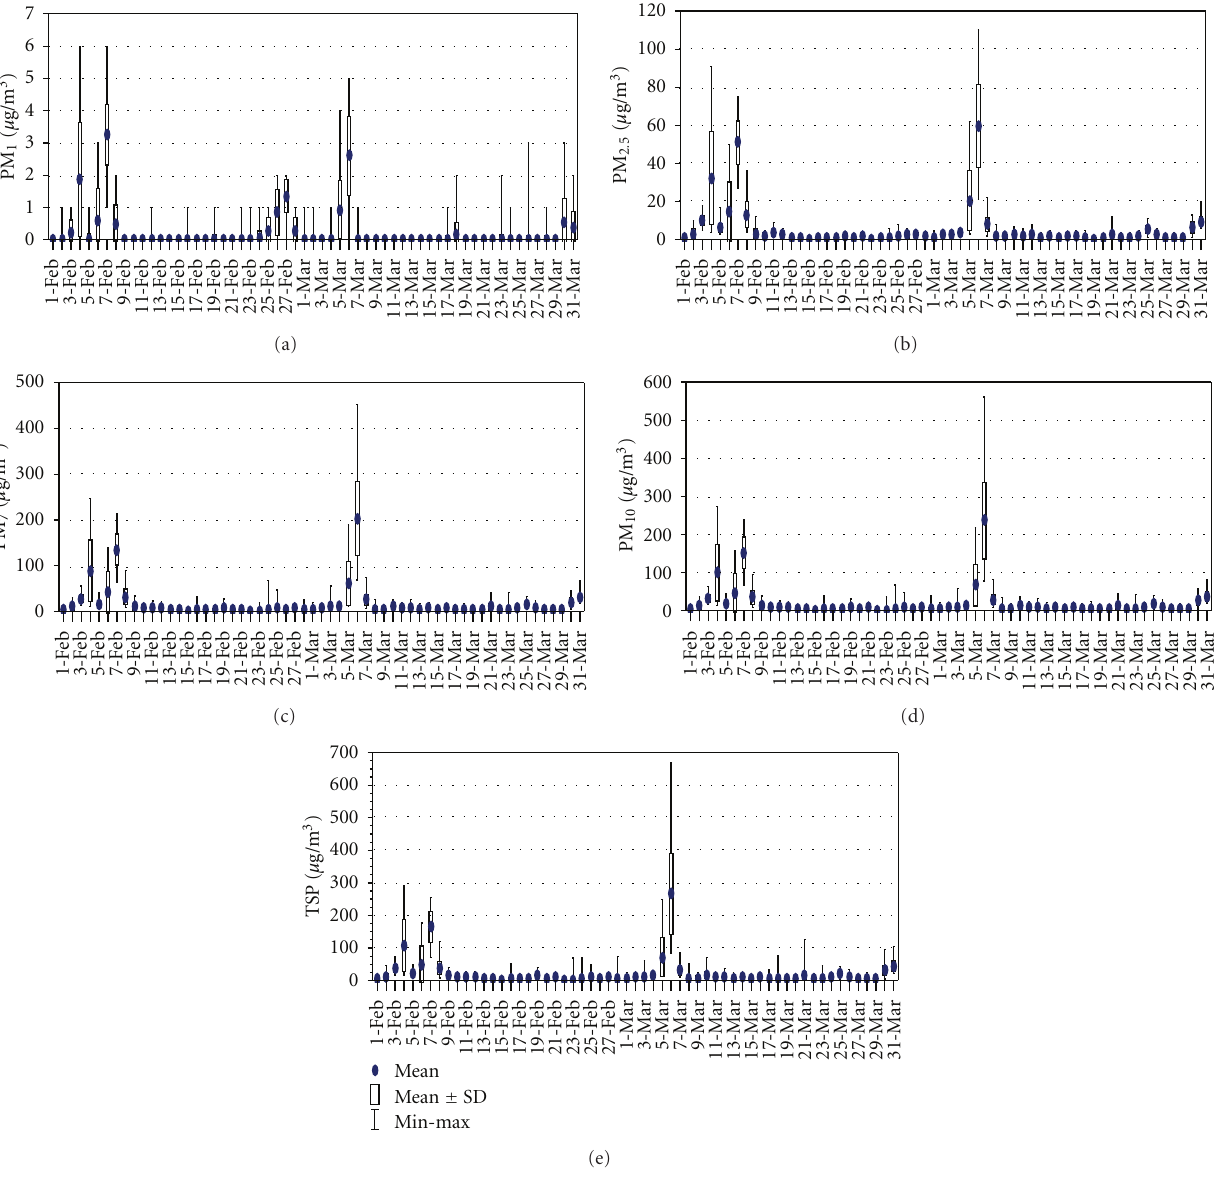
Figure 7: Daily Box and Whiskers plots for PMs recorded on 3-minute basis during the period February-March 2009. Middle point refers to mean value, box to ± standard deviation and Whisker to min-max